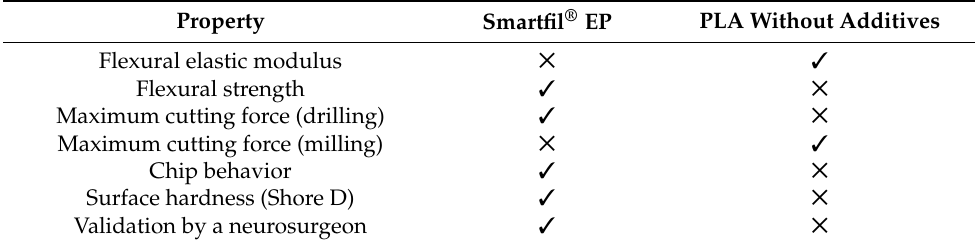
Table 1. Criteria for the choice of material for the skull model [16]. Property Smartfil ® EP PLA Without Additives Flexural elastic